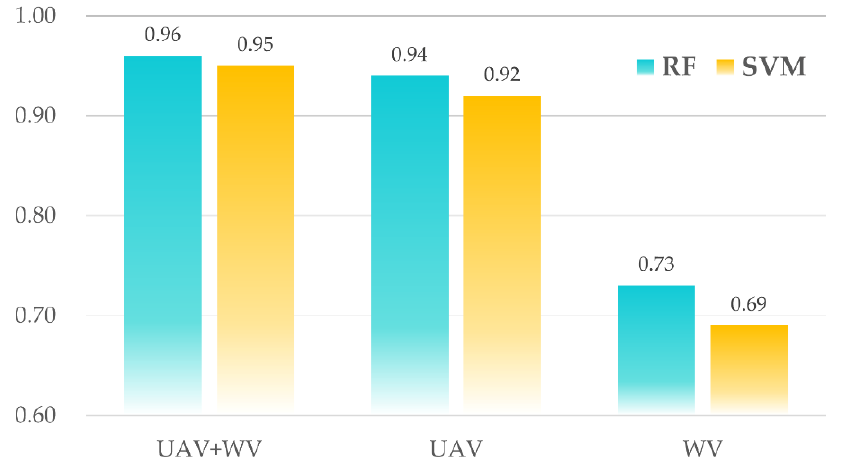
Figure 7. Comparison of mangrove classification accuracy with different data and methods.